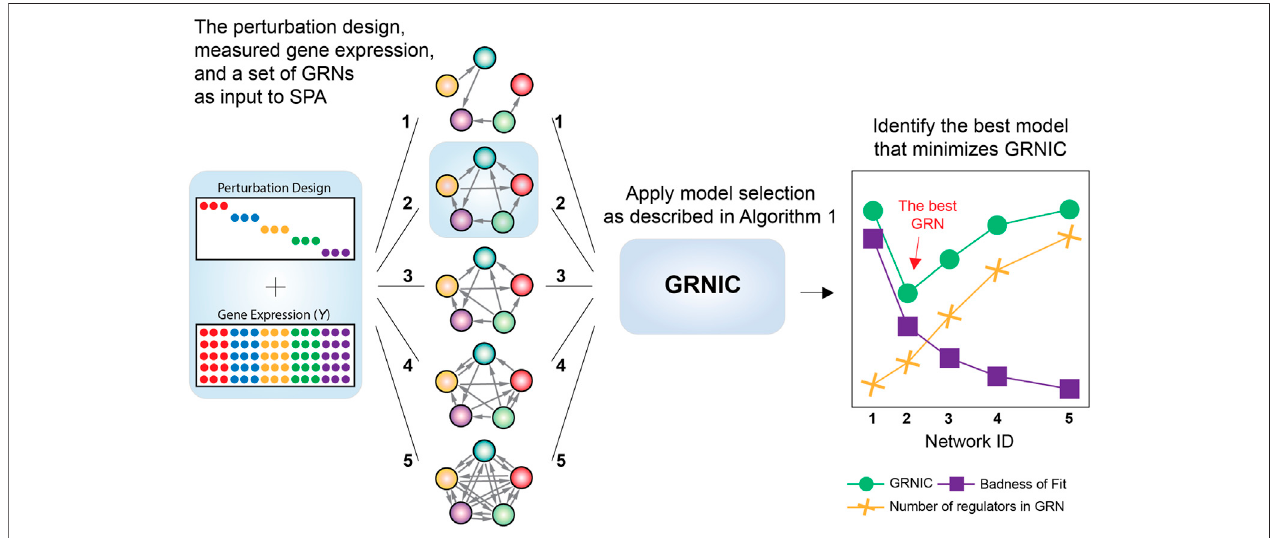
FIGURE1| Work fl owofSPA.SPAtakesasetofinferredGRNswithvaryingsparsities,themeasuredgeneexpressioninfoldchanges,andtheperturbationdesign as input. It then uses the GRN Information Criterion (GRNIC) as described in Algorithm 1 and identi fi es the GRN that minimizes GRNIC as the best GRN.